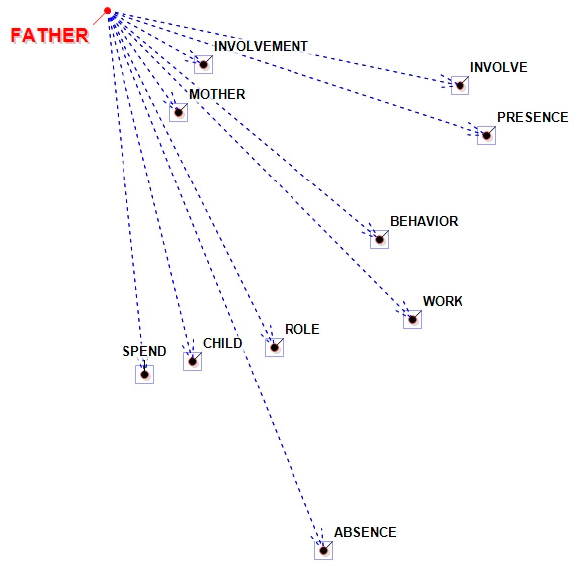
Figure 7. Successors of “father”.